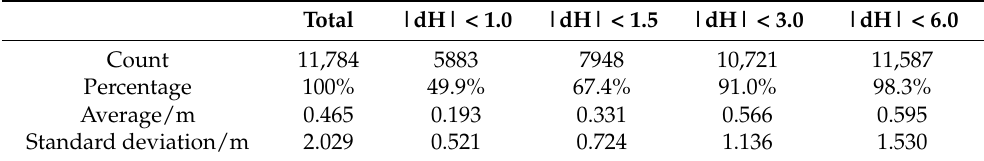
Figure 11. Height discrepancy histogram of DSM and extracted ATLAS LPs. Table 4. Height discrepancies of DSM and extracted ATLAS LPs.